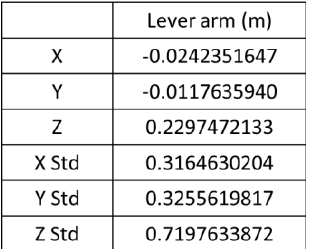
Table 2. Lever arm calibration result